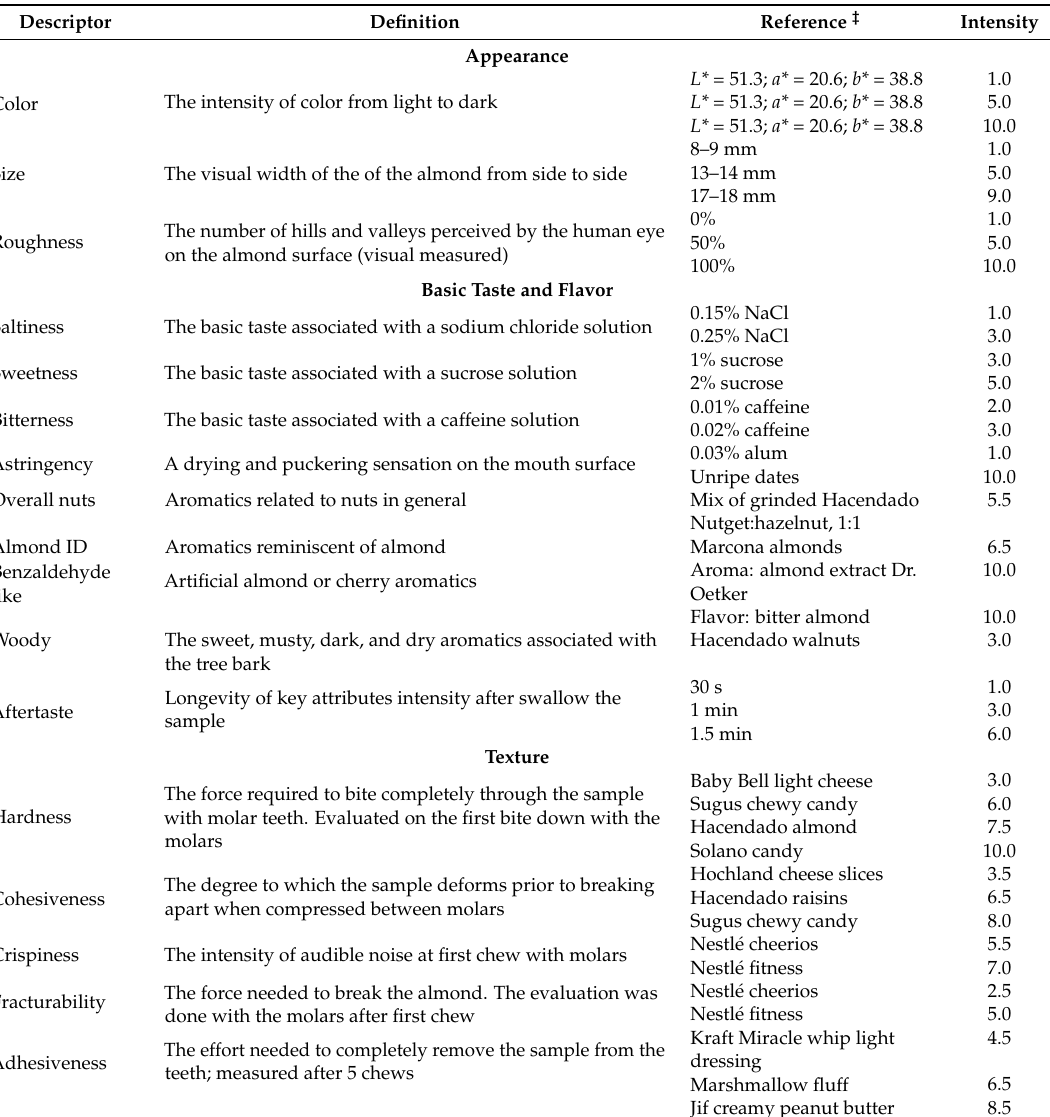
Table 1. Sensory attributes, reference materials, and their corresponding intensities, used for the descriptive analysis of